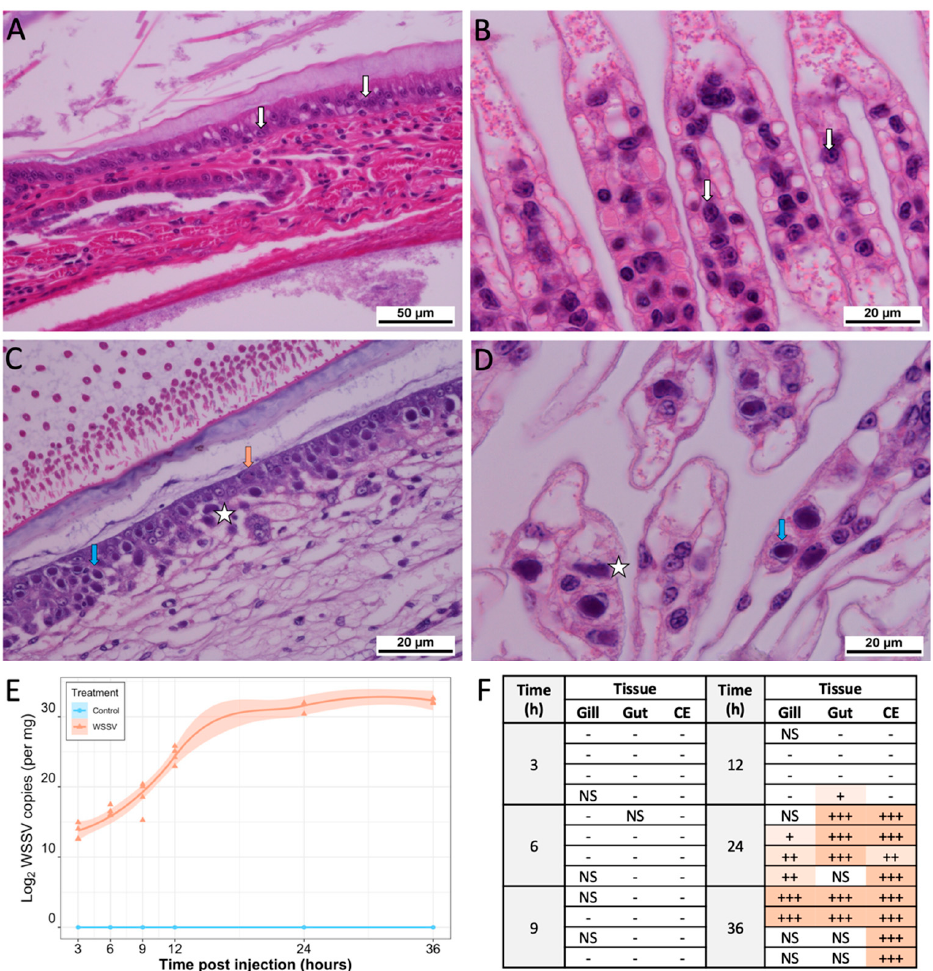
Figure 2. Phenotypic evidence for infection status in control and WSSV-injected treatments. Shrimp from control and WSSV-injected groups were subjected to histological screening, using haematoxylin and eosin staining with light microscopy, for signs of WSSV infection in the gill, gut, and cuticular epithelium tissue. ( A ) Control gut and ( B ) control gill tissues contain small, regularly shaped nuclei with basophilic stain (white arrow). ( C ) Nuclei infected with WSSV in the gut and ( D ) gills were enlarged. During early infection their chromatin was marginalised and large inclusion bodies stained homogeneous eosinophilic (orange arrow). As the infection progressed, these inclusions became increasingly basophilic (blue arrow) before disintegrating so that the contents fused with the cytoplasm (left of white star). ( E ) Scatter plot with smoothed conditional local regression line depicting log2 WSSV copy number over time, measured by qPCR. Shaded areas represent 95% confidence interval. ( F ) Table depicting the infection status of gill, gut, and cuticular epithelium (CE) tissue of WSSV-injected shrimp at each timepoint following WSSV injection. No infection is denoted by “-”, mild infection (few enlarged nuclei present) by “+”, moderate infection (at least 50% of cells within the target tissue present enlarged nuclei) by “++”, and severe infection (over 80% of the cells within the target tissue present enlarged nuclei) by “+++”. Tissues that were not able to be sectioned are marked